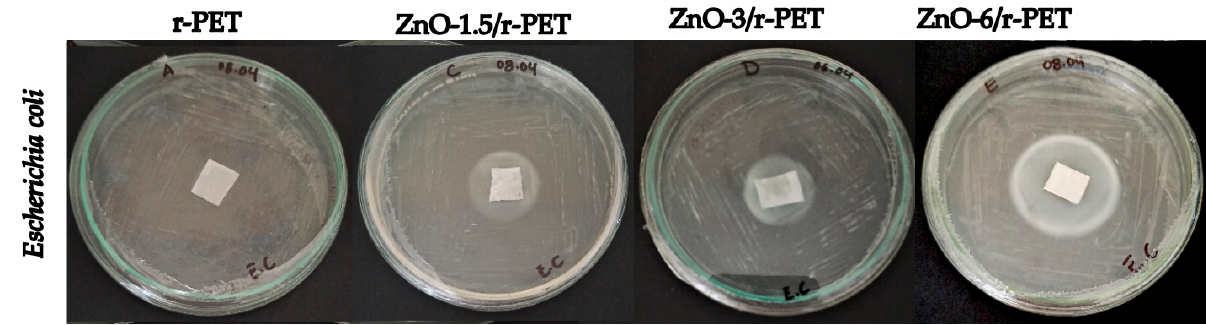
Figure 5. Antibacterial tests Escherichia coli in r-PET composite fibers.